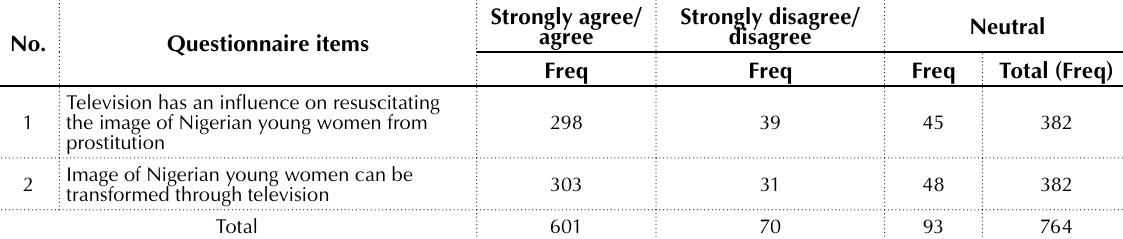
Table 3. Coded responses on the influence of MTN foundation restructured schools connect project as a corporate social responsibility strategy on the corporate image of MTN telecom services provider